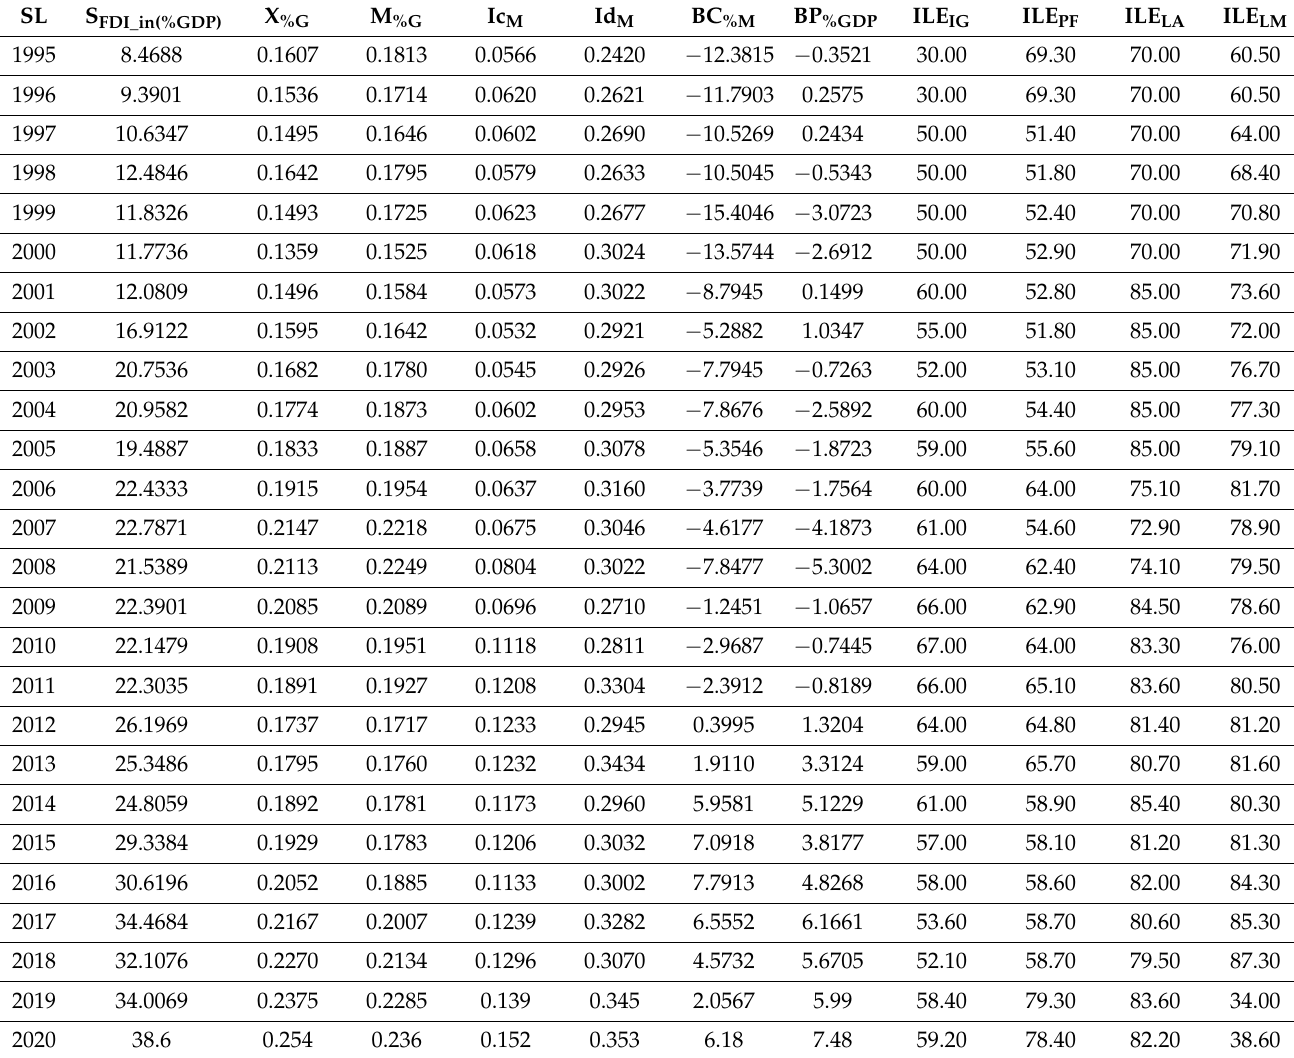
Table A4. Values of economic indicators for